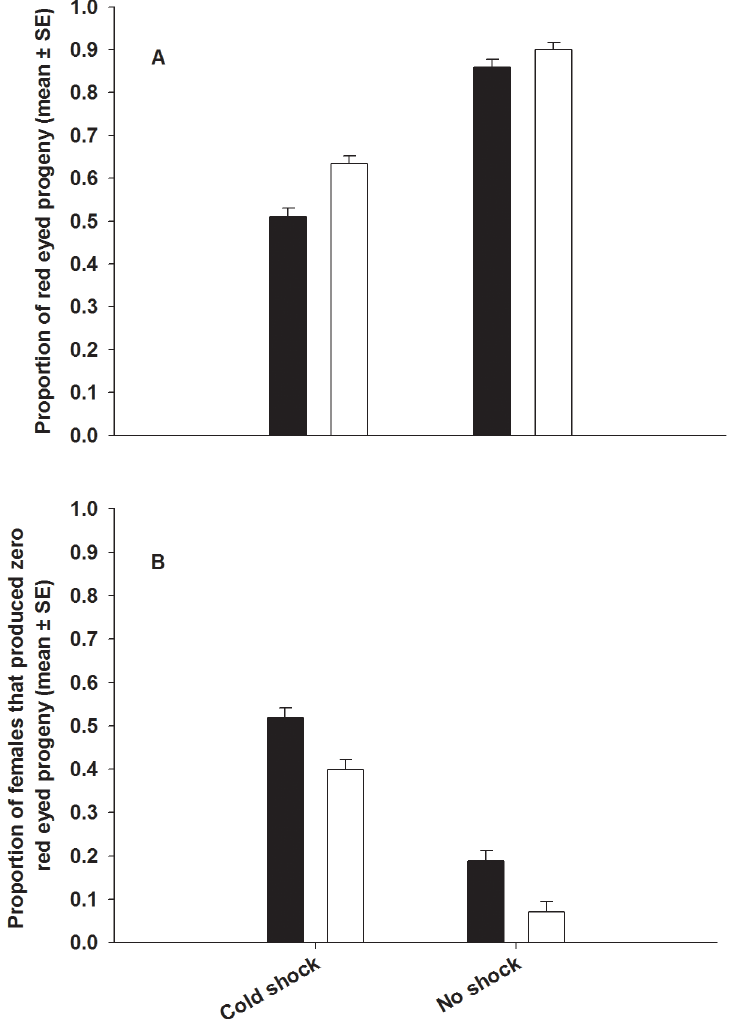
Fig 6. Effect of cold shock on sperm offense ability (P2). Closed bars represent the FCB and open bars represent the FSB populations. Since the females and competitors males have recessive scarlet eye marker and the FSB and FCB males have dominant red eye marker, progeny sired by FSB and FCB males will show red eye color. Hence, in this experiment, the proportion of red eyed progeny is an indicator of sperm offense ability. (A) These data come from females that produced at least one progeny from the FSB or FCB male (that is non-zero sperm offense ability). Compared to FCB males, FSB males had higher sperm offense ability under cold shocked and non-shocked conditions. Selection and treatment had significant effect on P2. However, selection × treatment interaction was not significant. (B) Proportion of males that had zero-sperm offense ability (P2). Significantly lesser proportion of FSB males had zero sperm offense compared to FCB males. Selection and treatment effects were significant. However, selection × treatment interaction was not